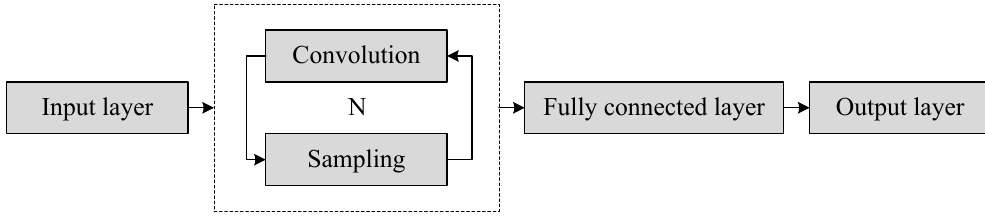
Figure 1. The simplified structure of deep neural network based on convolutional neural networks (CNNs).